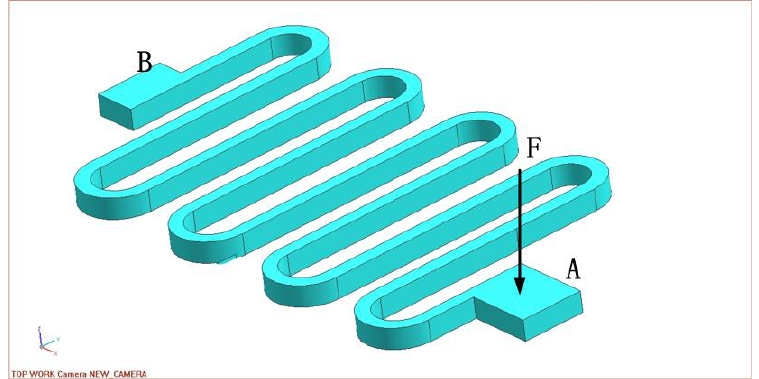
Figure 3. The analysis of a single beam.